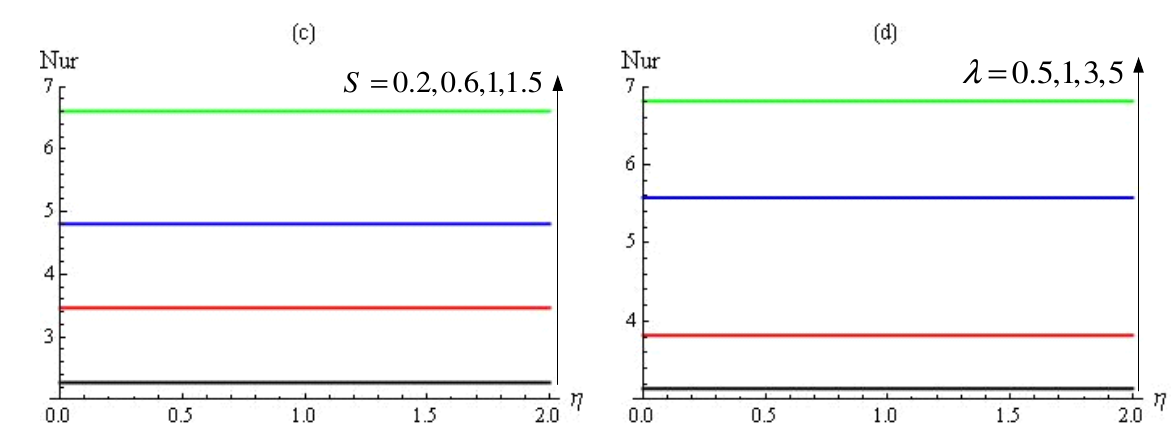
Figure 8. Profiles of the reduced Nusselt number (Nur) as a function of η for different values of the included parameters; in particular for ( a ) R , ( b ) M , ( c ) S and ( d ) λ